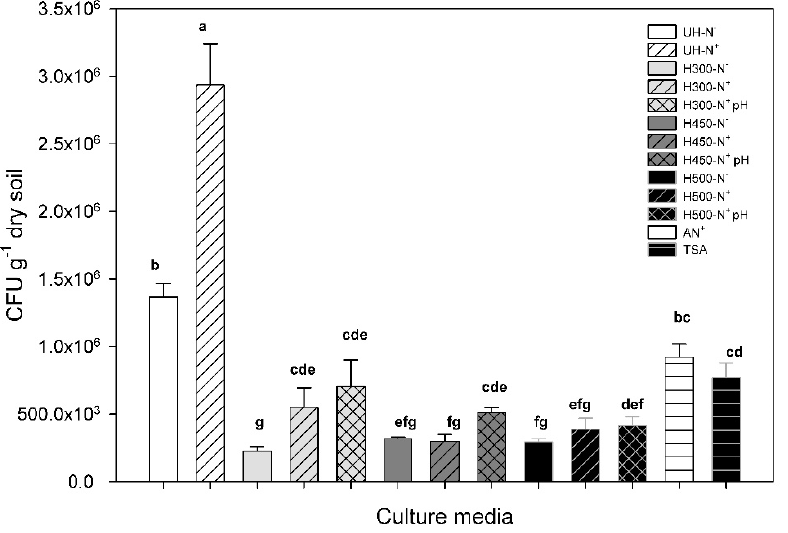
Figure 6. Mean value (± SE) of CFUs counted in each culture media (Table 1). Different letters indicate significant differences among treatments according to Tukey’s test ( α = 0.05). The codes of the different soil:water extract media are described in Table 1. AN + media was created only with nutrient solution as control of the application of nutrients amendment. TSA (Tryptic Soy Agar) was used as a reference for typical culture media to isolate soil micro-organisms.